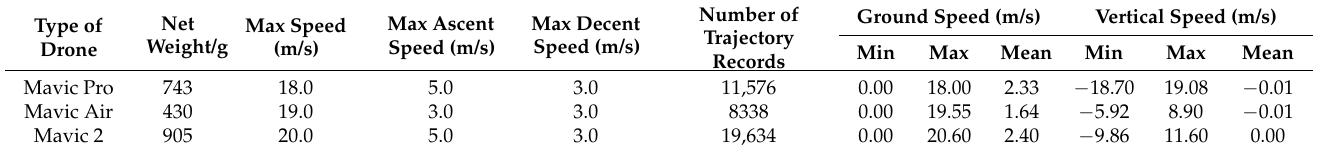
Table 3. Summary of the collected data for the